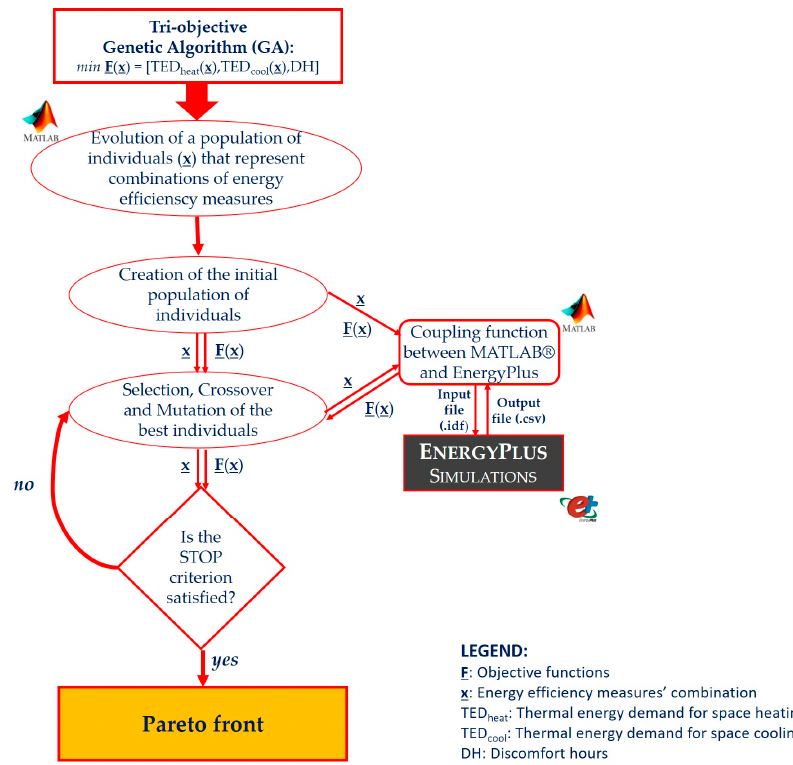
Figure 2. Scheme of the 1st optimization stage, adapted from [32].